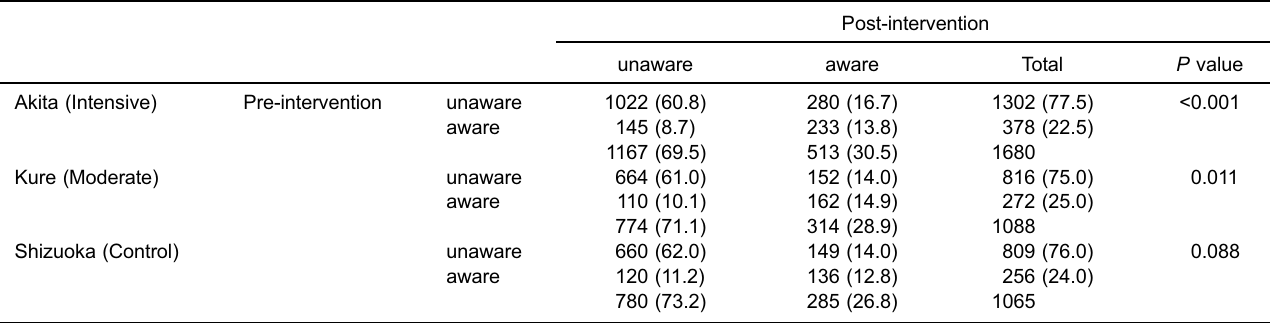
Post-intervention unaware aware Total P value